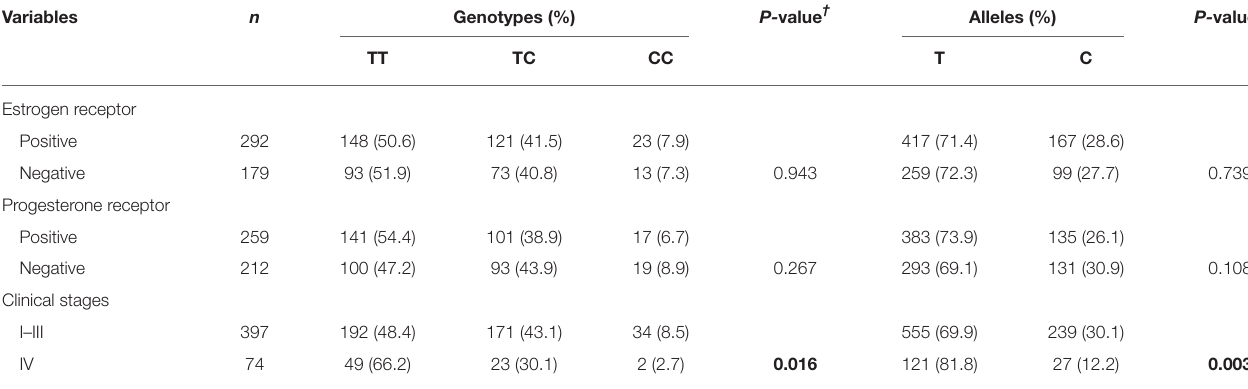
TABLE 3 | The associations between rs11730582 and clinical features of BRC. Variables